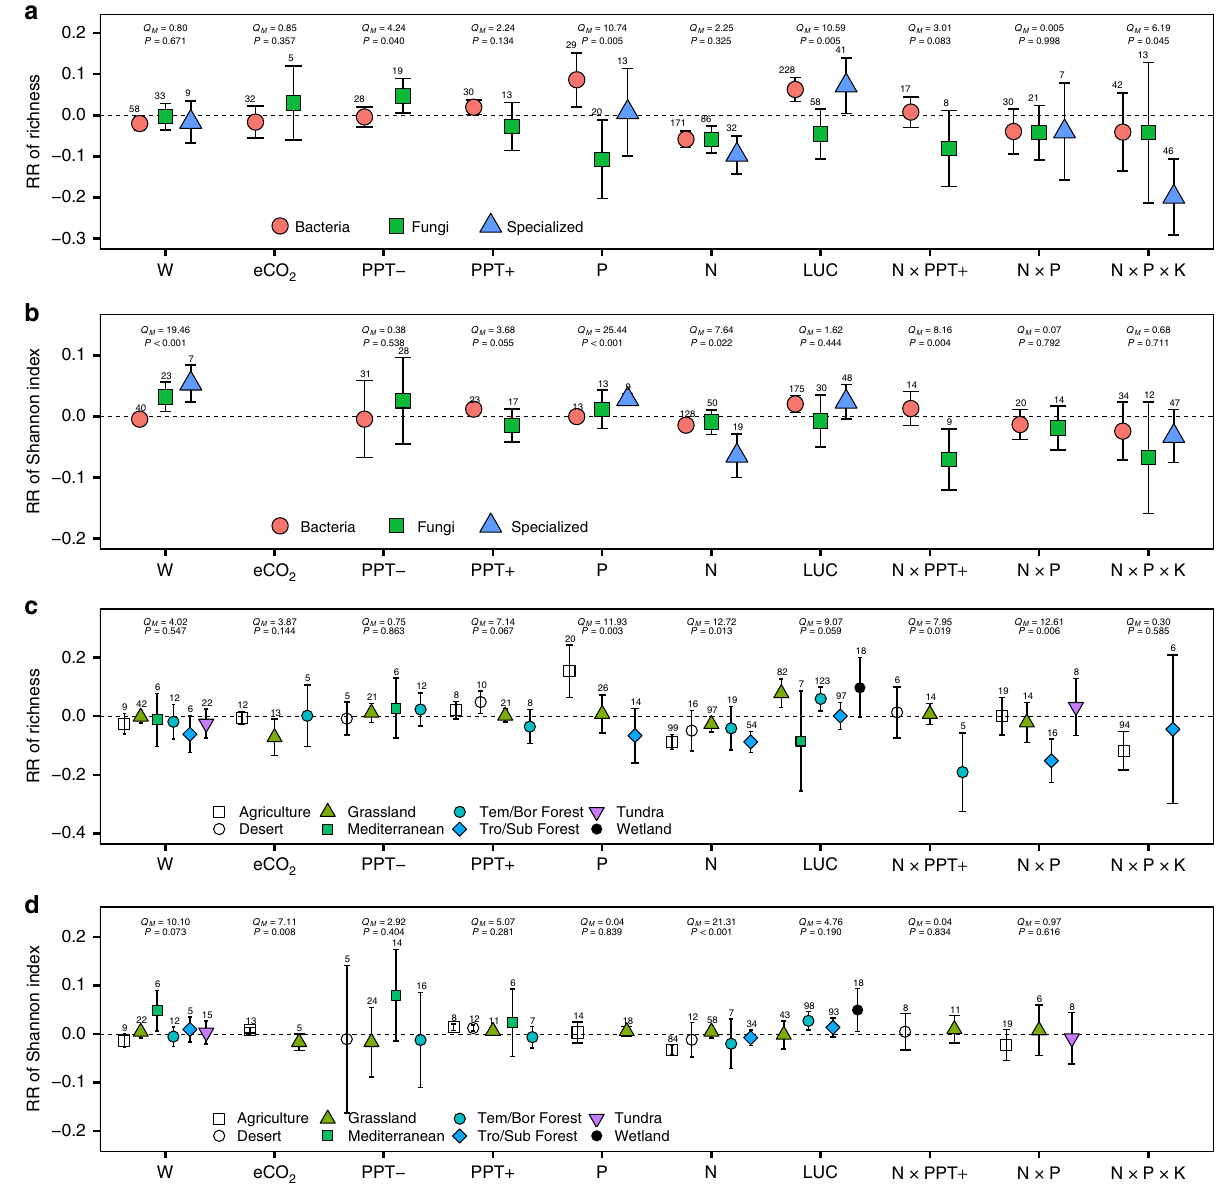
Fig. 2 Responses of microbial alpha diversity across microbial groups and biomes. a Response ratio (RR) of richness across microbial groups. b RR of Shannon index across microbial groups. c RR of richness across biomes. d RR of Shannon index across biomes. Weighted means and their 95% con fi dence intervals of RRs are given. The numbers at the top of the con fi dence intervals represent the sample sizes. The signi fi cances of microbial groups and biome types are tested by the omnibus test ( Q M ). W warming, eCO 2 carbon-dioxide enrichment, PPT − decreased precipitation, PPT + increased precipitation, P phosphorous addition, N nitrogen addition, LUC land-use change, W × eCO 2 warming plus carbon-dioxide enrichment, N × PPT + nitrogen addition plus increased precipitation, N × P nitrogen plus phosphorous addition, N × P × K nitrogen plus phosphorous plus potassium addition. Tem/Bor temperate/ boreal. Tro/Sub tropical/subtropical. Source data are provided as a Source Data fi